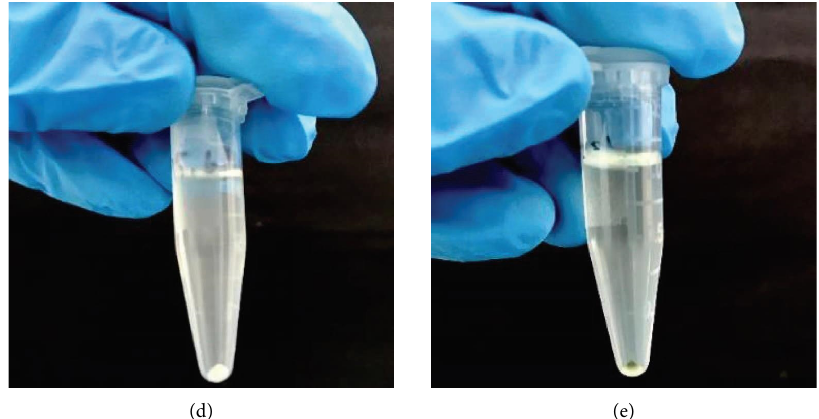
Figure 6: Te golden-yellow color of staphyloxanthin production at (a) 125 μ g/mL concentration; (b) 62.5 μ g/mL concentration; (c)